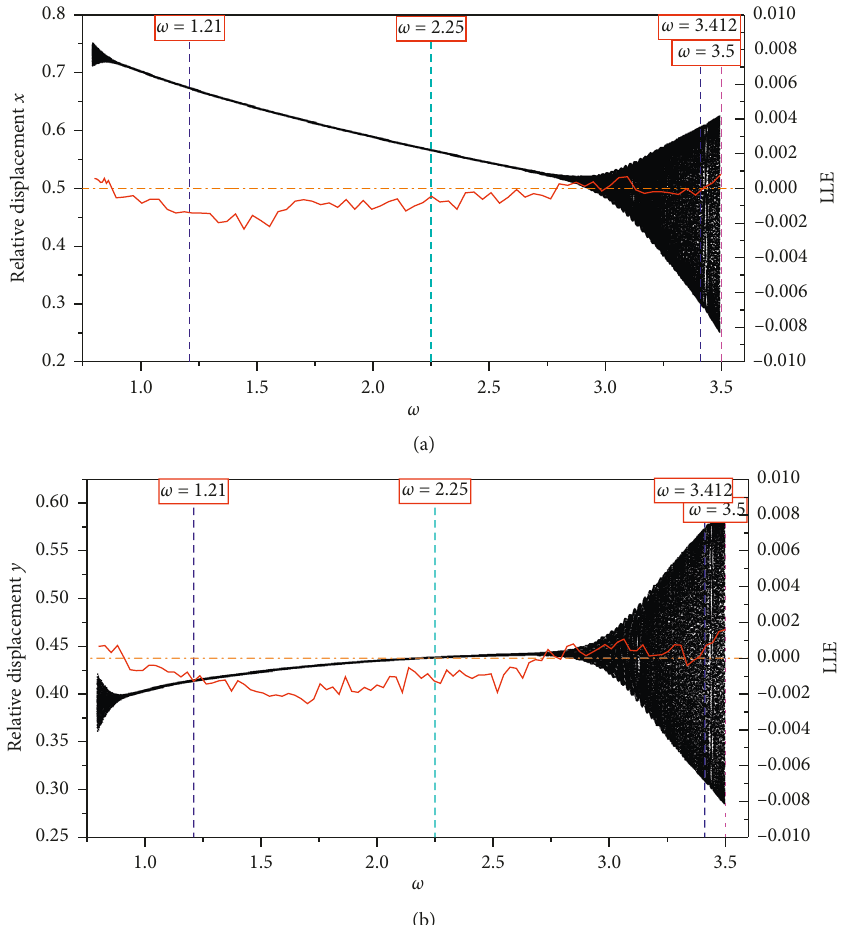
Figure 3: Dynamic bifurcation diagram and its LLE: (a) x ; (b) y .